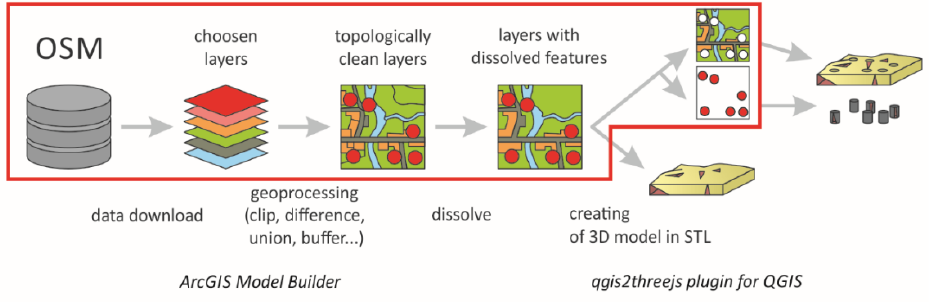
Figure 6. GIS block scheme of the tactile map creation workflow.